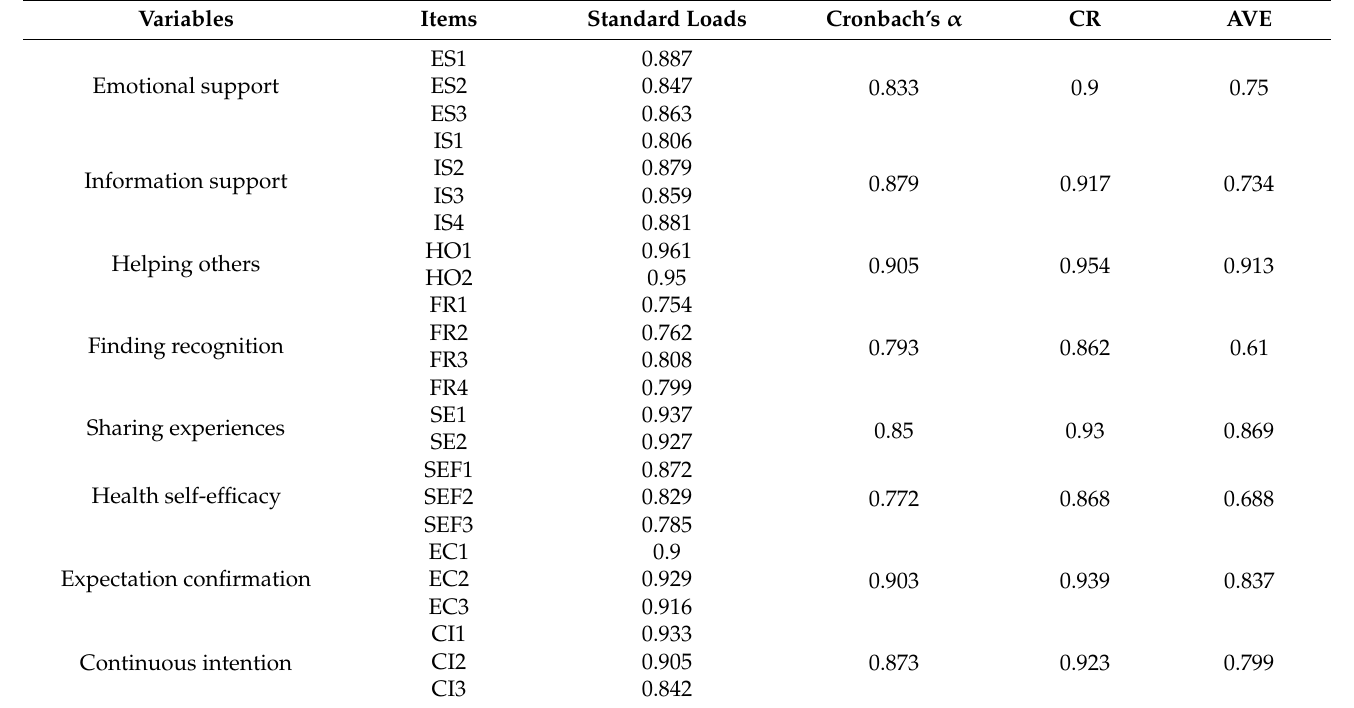
Table 4. Confirmatory factor analysis.